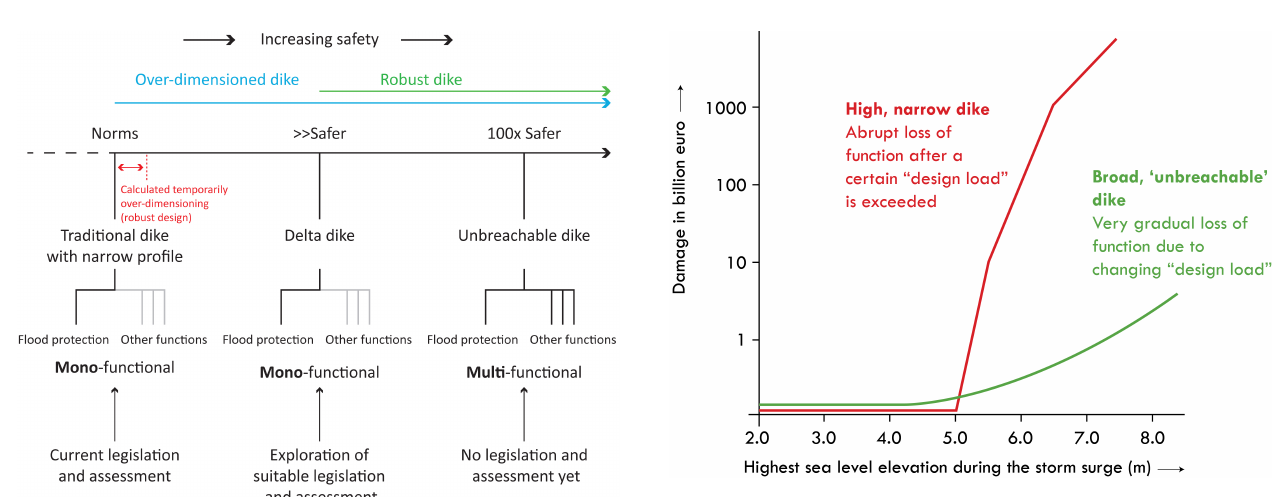
Fig. 2. Damage functions of narrow and broad dikes (Vellinga, 2008).